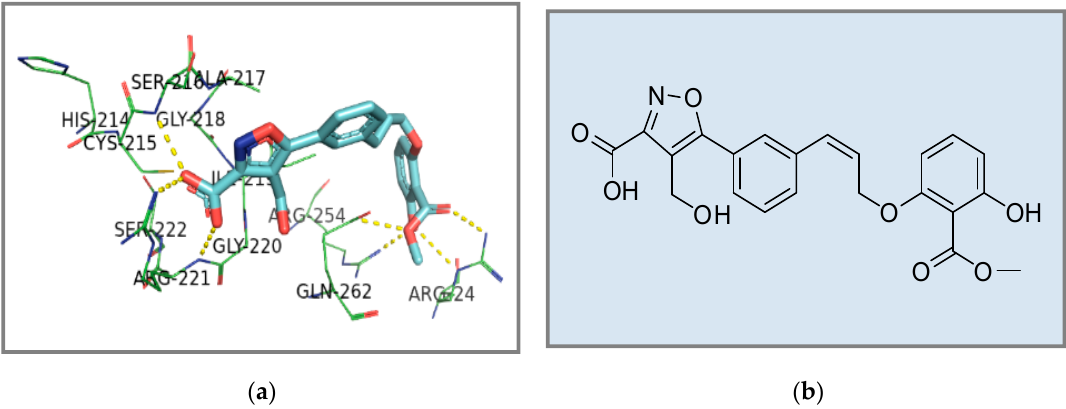
Figure 3. ( a ) protein tyrosine phosphatase 1B PTP1B (1XBO) amino acid residues around the original ligand; ( b ) the native ligand structure. The colors represent the element or atom (Red: Oxygen; Blue: Nitrogen; Yellow: Sulphur; Orange: Phosphor; Green: Carbon of the receptor residues; Cyan: Carbon of ligand; Dotted Yellow line: Interaction between the atoms).